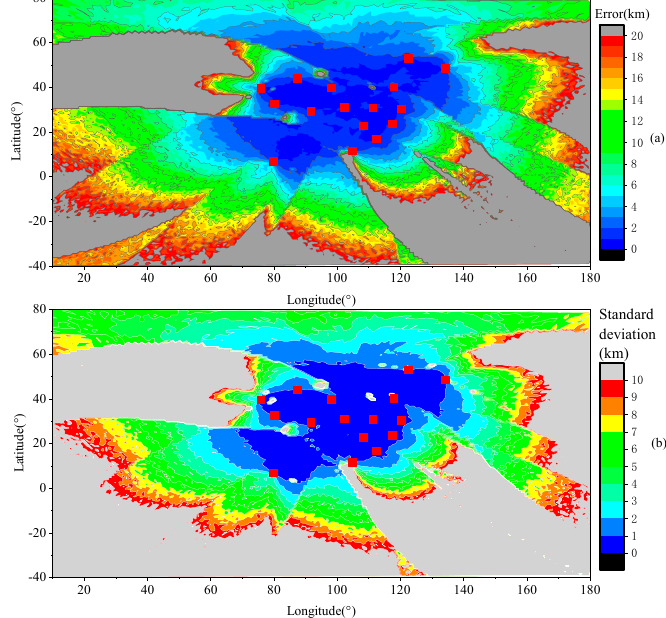
Figure 10. Monte Carlo error simulation result of Asia-Pacific Lightning Location Network (APLLN) by using the unimproved Levenberg–Marquardt (L–M) positioning algorithm. ( a ) Location error distribution. ( b ) Standard deviation distribution. Each red box represents a site.